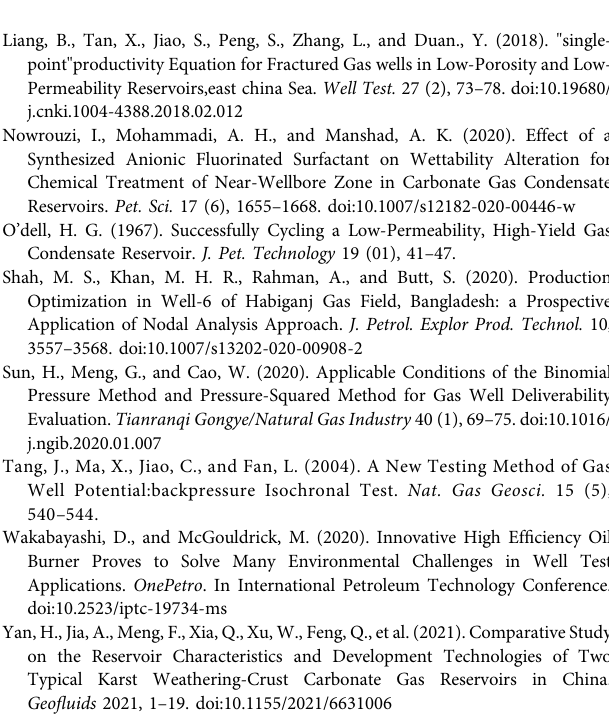
Table 5 indicates that the average relative difference based on value of 7.58% from the empirical